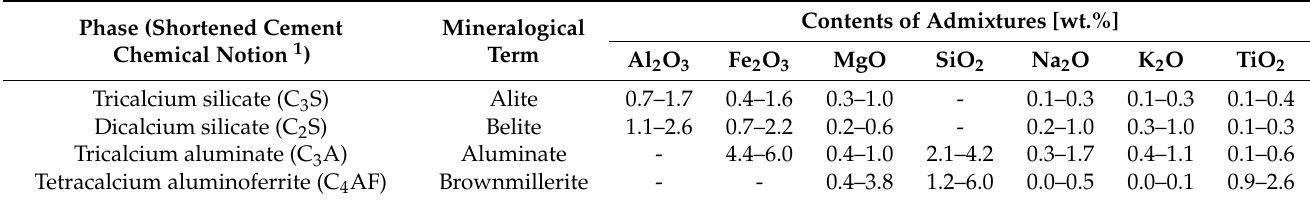
Table 1. Content of admixtures in clinker mineral phases (wt.%).